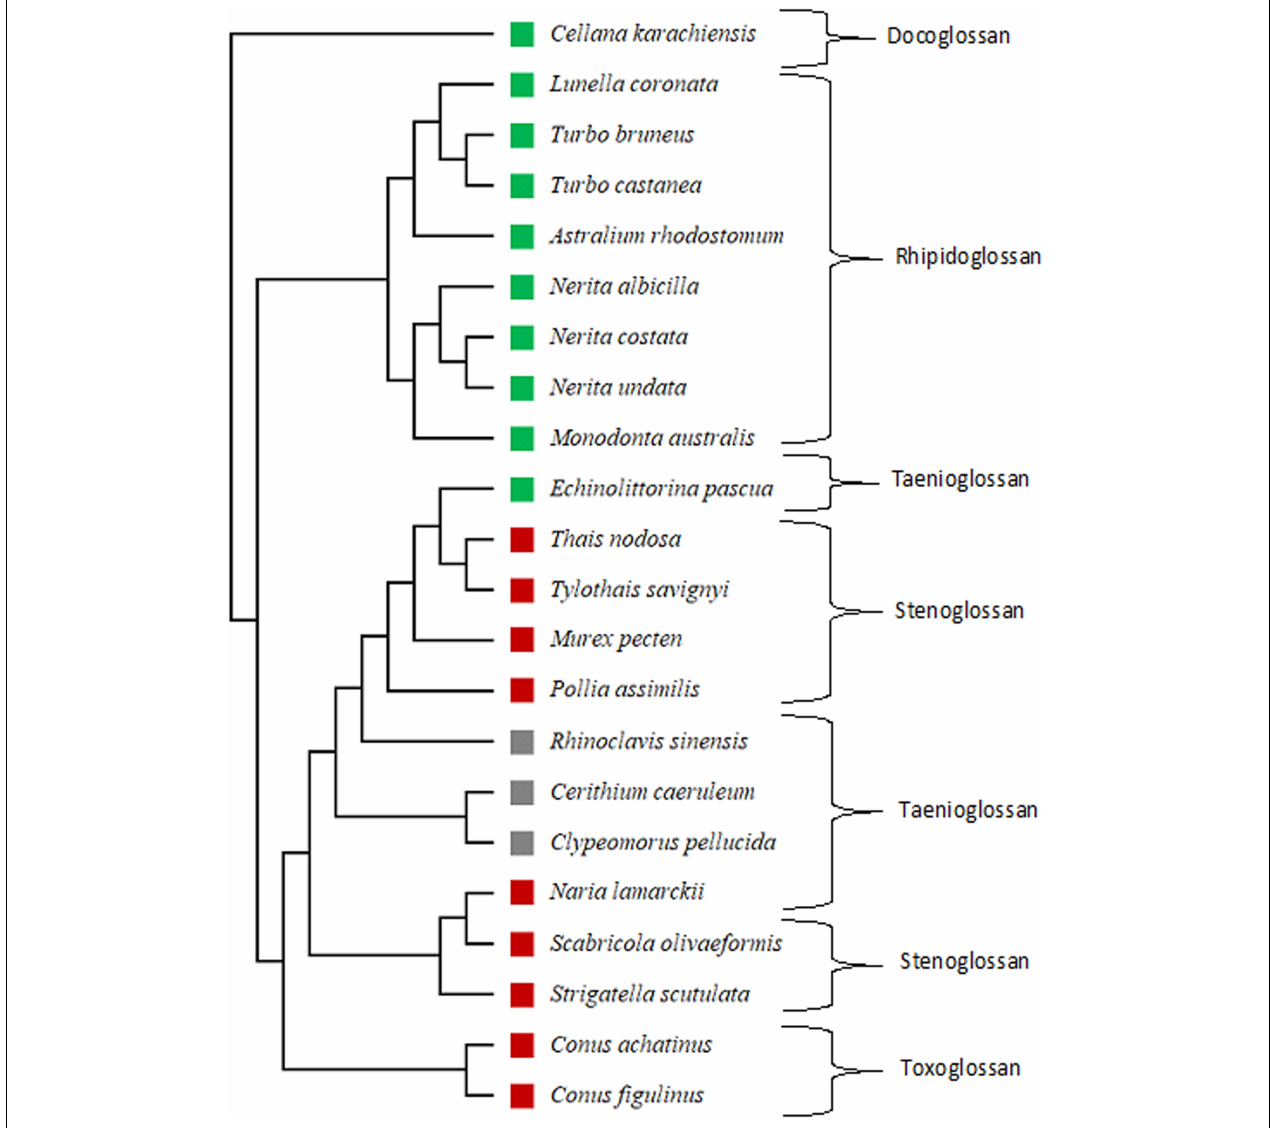
FIGURE 8 | Phylogenetic tree based on cytochrome oxidase I ( COI ) gene for gastropod analyzed using UPGMA (without out-group) with Jones-Taylor-Thornton (JTT) estimate models of amino acid replacement with 1,000 bootstrap replicates in Molecular Evolutionary Genetics Analysis (MEGA11) software. Green color square: herbivore; gray color square: detritus feeder; red color square: